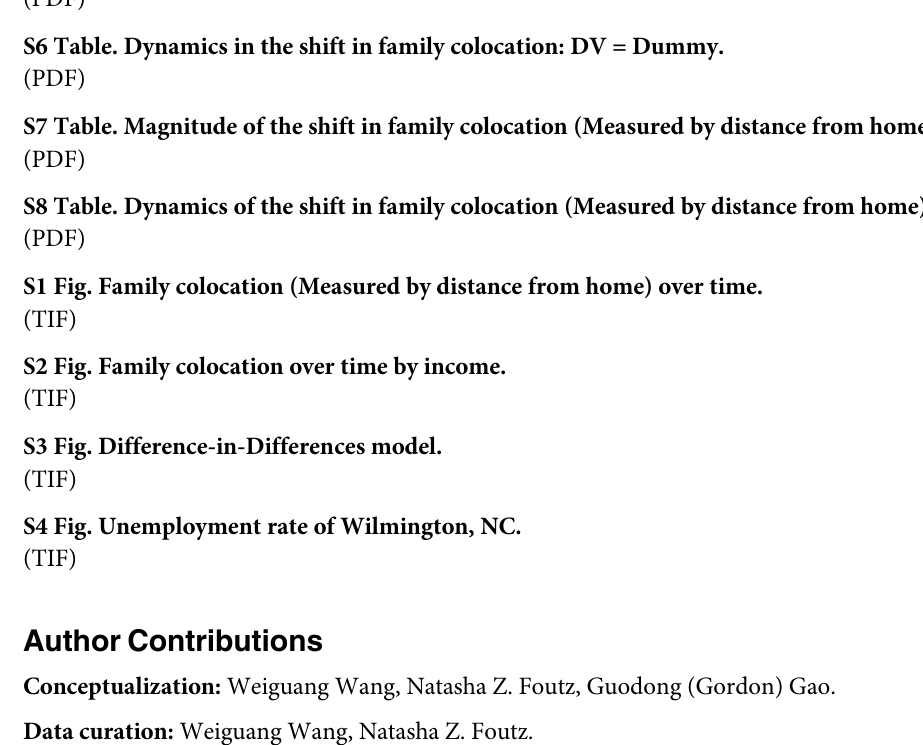
S3 Fig. Difference-in-Differences model. S4 Fig. Unemployment rate of Wilmington,